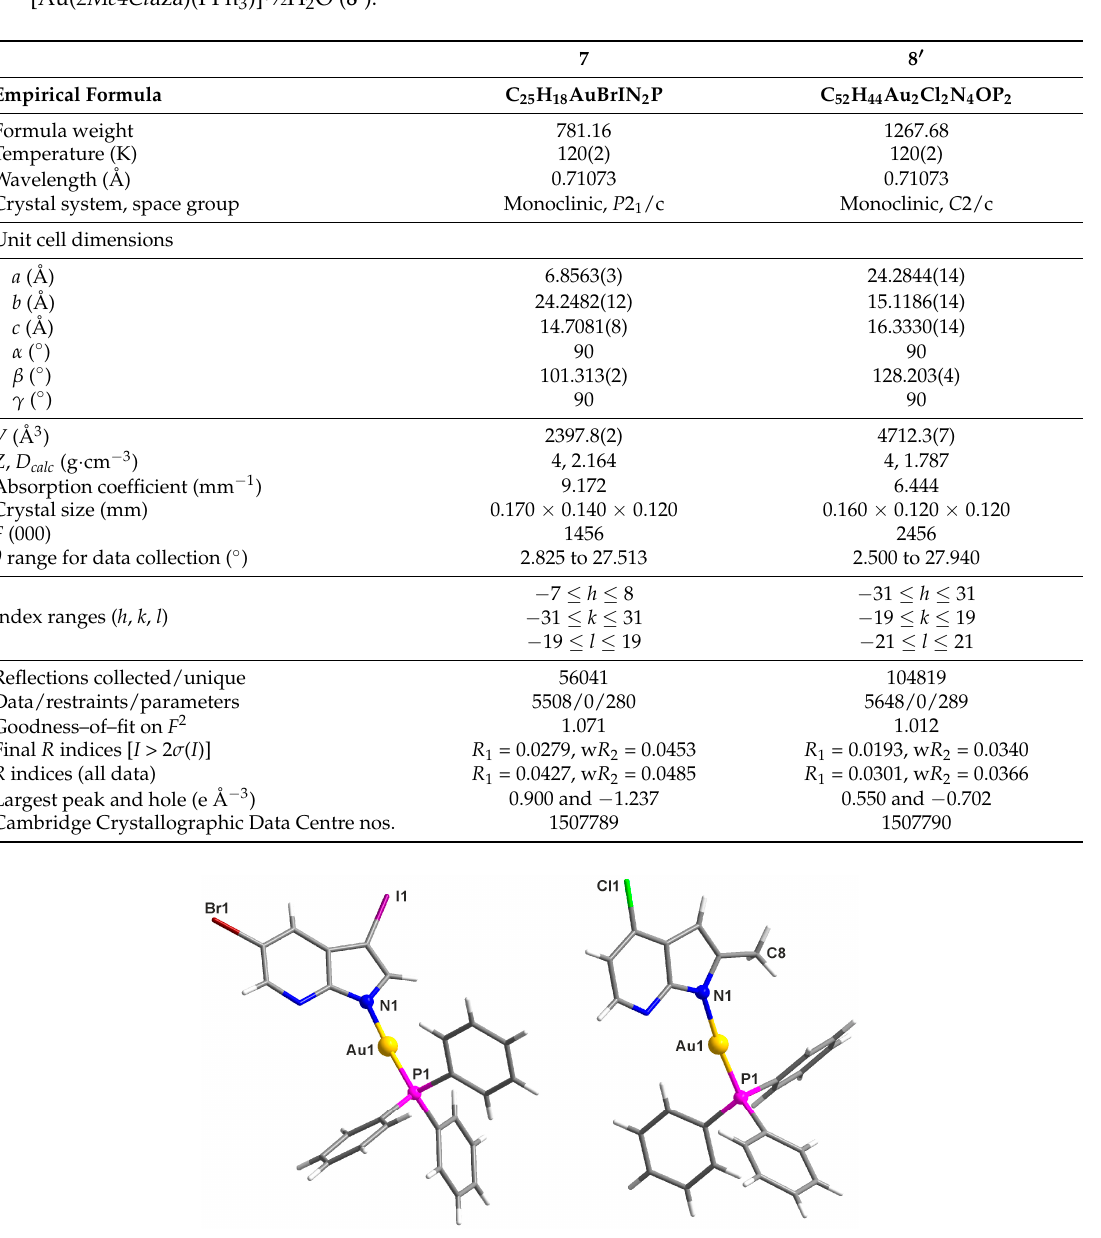
Figure 2. The molecular structures of [Au( 3I5Br aza)(PPh 3 )] ( 7 ; left ) and [Au( 2Me4Cl aza)(PPh 3 )]·½H 2 O ( 8 ′ ; right ), the ½H 2 O molecule of crystallization was omitted for clarity.